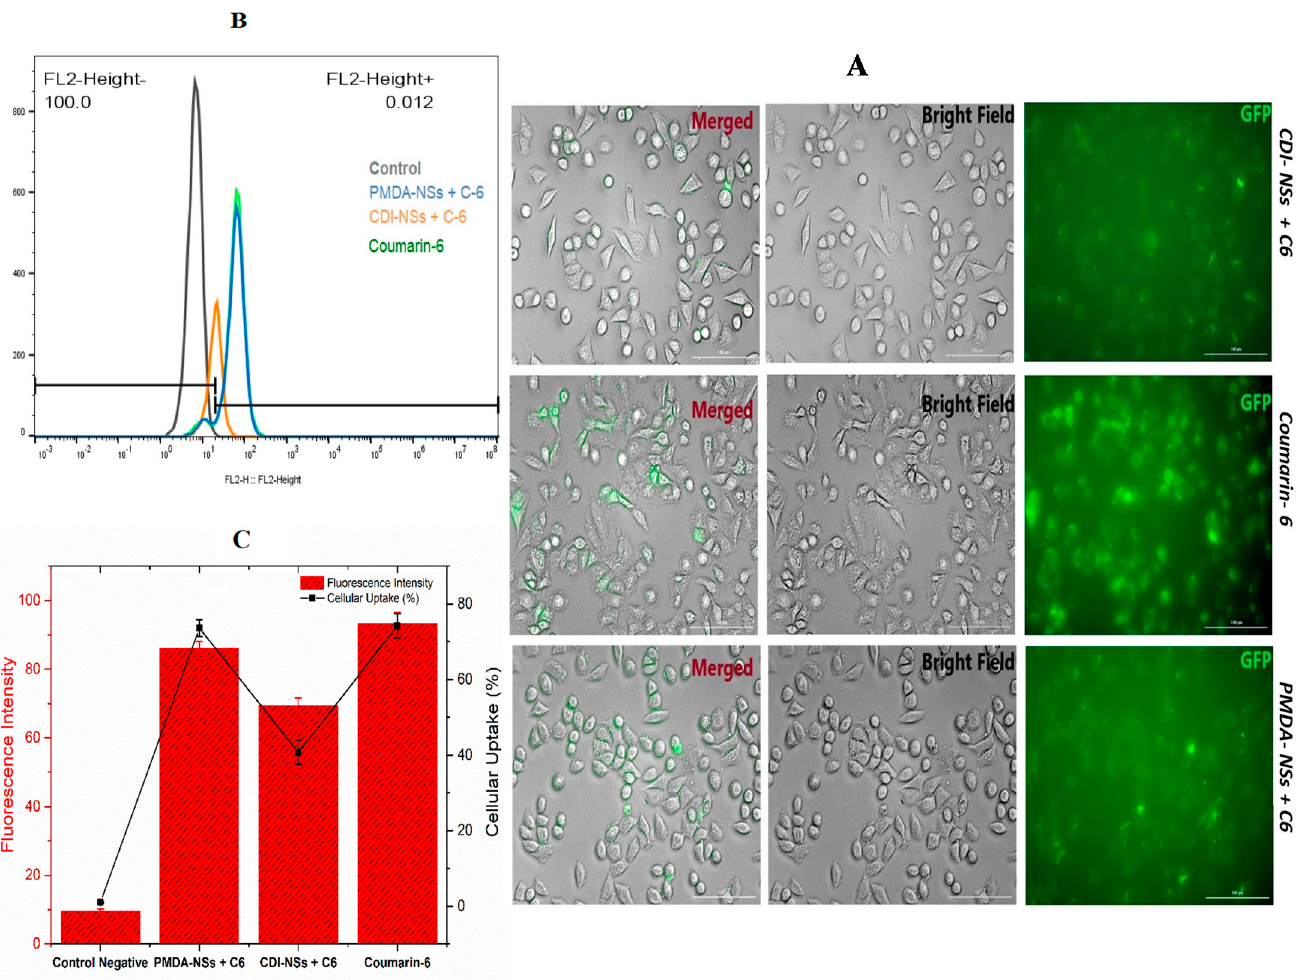
Figure 5. Uptake of coumarin-6 labeled CDNSs on MCF-7 cells at 37 °C for 4 h was observed and investigated by fluorescent microscopy and flowcytometry. ( A ) was observed by fluorescence microscope; ( B , C ) were analysis of flowcytometry data; ( B ): Flowcytometry assay, ( C ): Mean of Fluorescence Intensity of MCF-7 cells by flowcytometry assay. Data are expressed as mean ± SD ( n = 3). One-way ANOVA analyses was used.